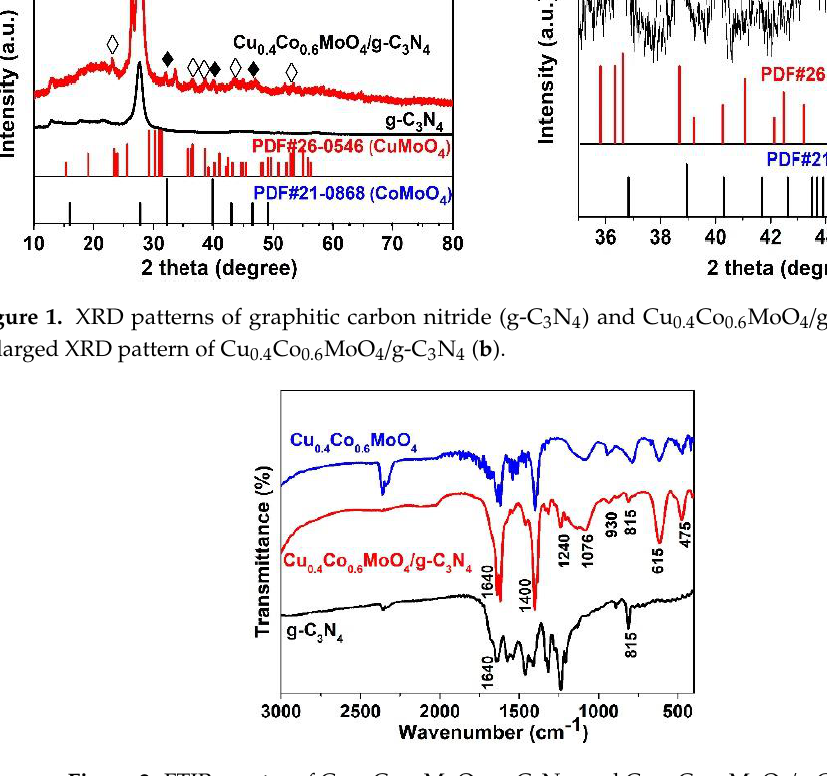
Figure 1. XRD patterns of graphitic carbon nitride (g-C 3 N 4 ) and Cu 0.4 Co 0.6 MoO 4 /g-C 3 N 4 ( a ) and enlarged XRD pattern of Cu 0.4 Co 0.6 MoO 4 /g-C 3 N 4 ( b ).